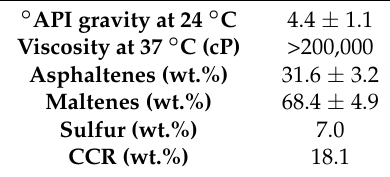
Table 8. Characteristics of the feedstock consisting of de-fined